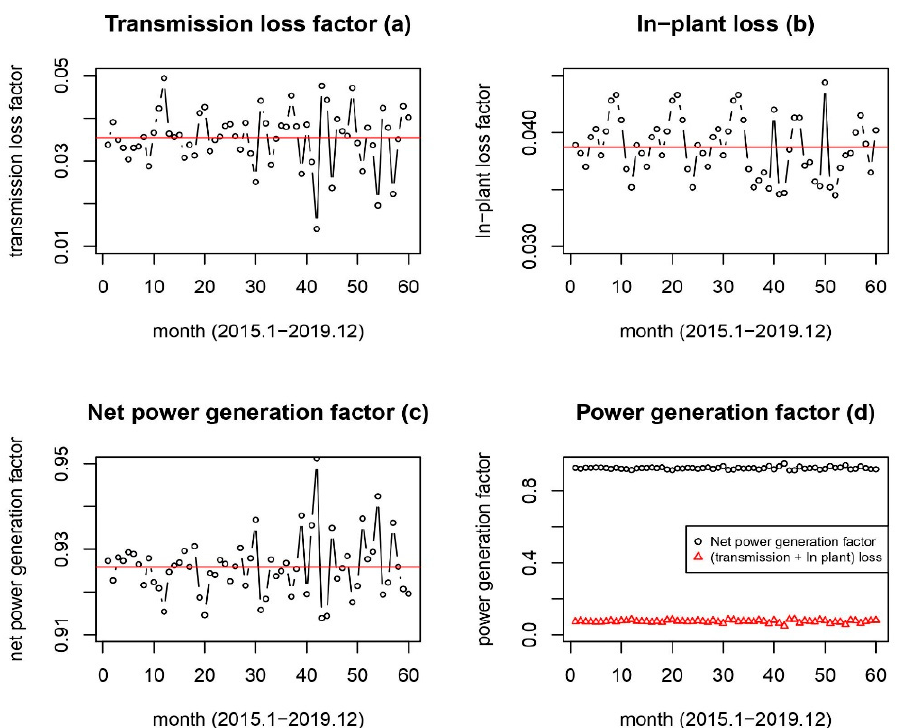
Figure 1. Variation of the transmission loss ( a ), in-plant loss ( b ), net power generation factor ( c ), and power generation factor ( d ).